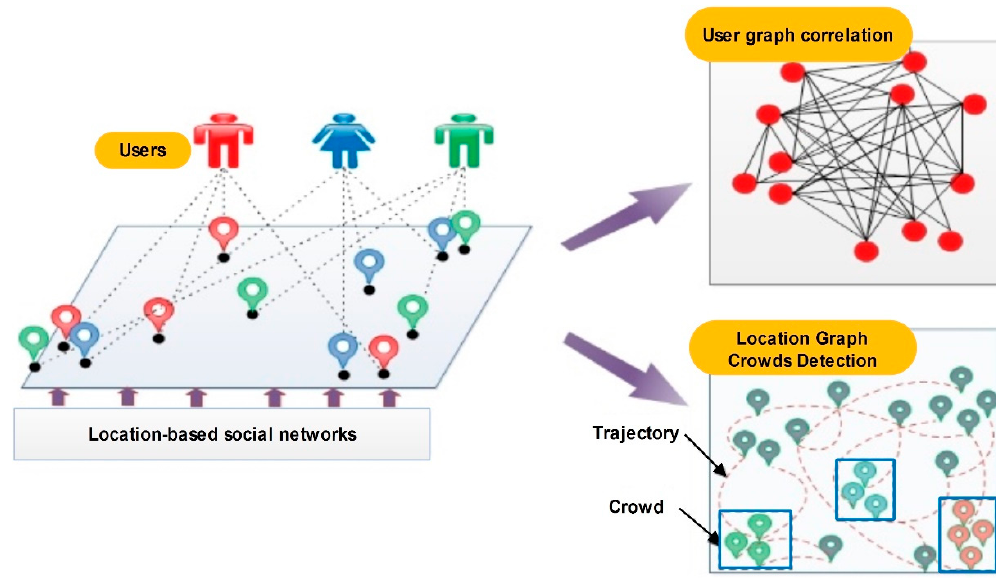
Figure 1. Human mobility based on location-based social networks (LBSNs).